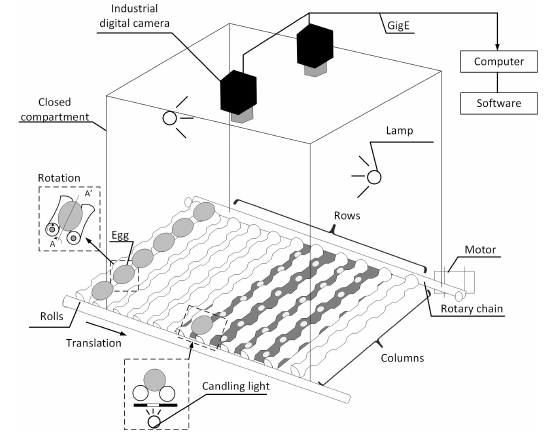
Figure 1. Egg inspection system.